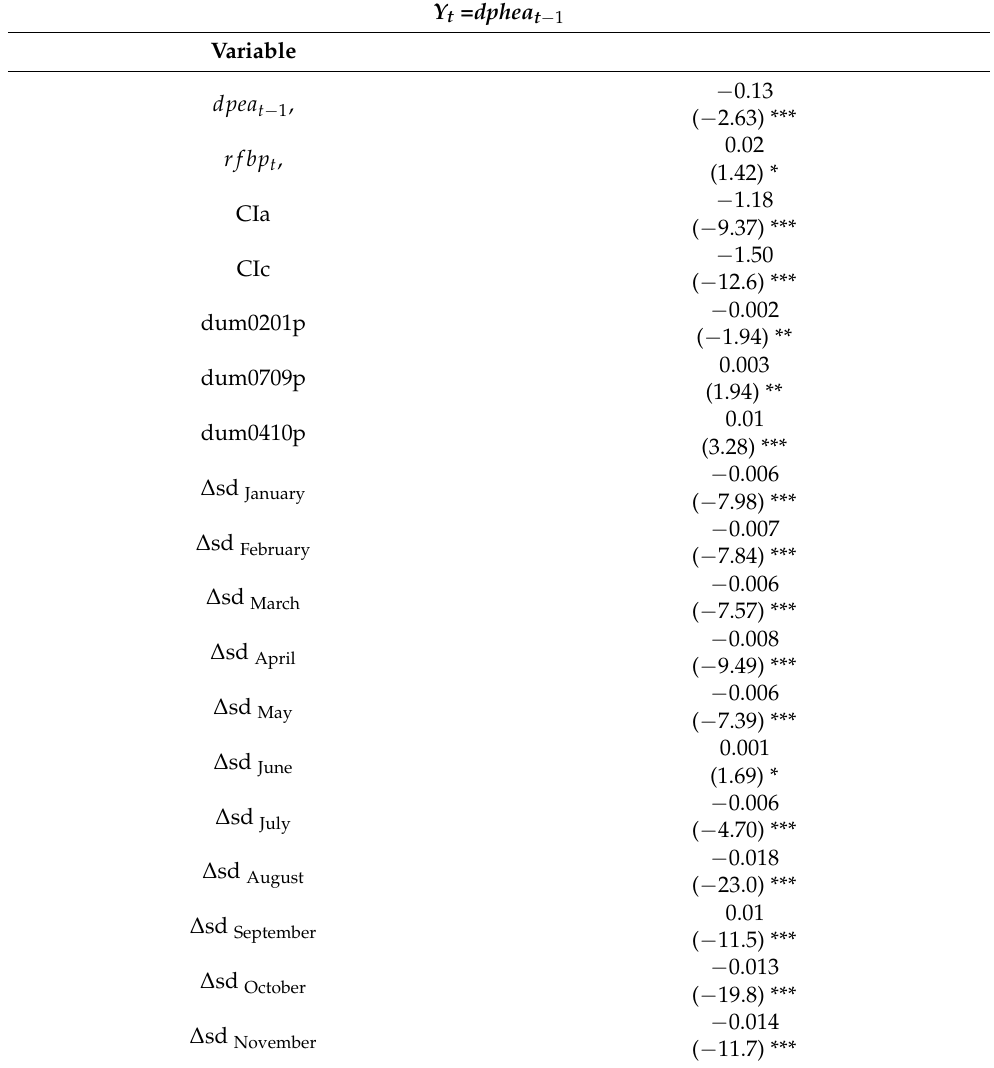
Table 4. Short-term effects on the hospitality industry prices in the